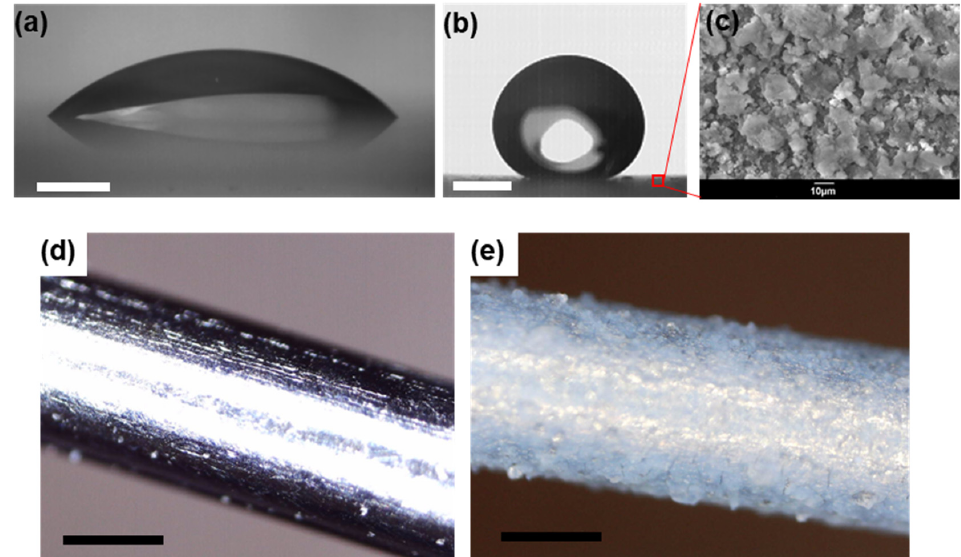
Figure 1. ( a , b ) A water droplet on the flat stainless-steel substrate and the flat superhydrophobic- coated stainless-steel substrate, respectively. Scale bars in ( a , b ) are 2 mm. ( c ) Scanning electron microscope image of the surface morphology of the superhydrophobic coating. Scale bar in ( c ) is 20 µm. ( d , e ) Micrographs of the bare stainless-steel wire and the superhydrophobic-coated wire, respectively. Scale bars in ( d , e ) are 3 mm.